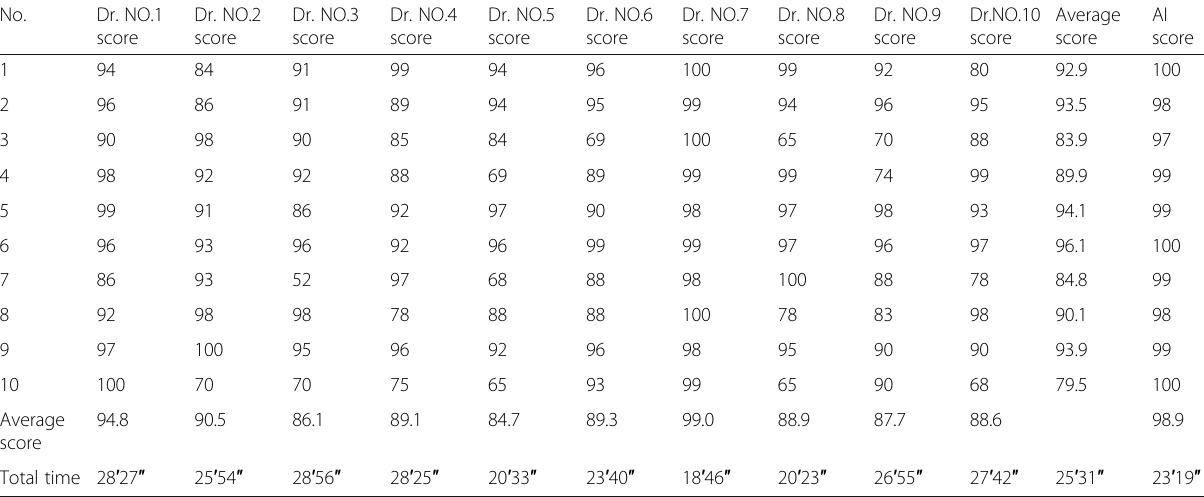
Table 4 Details for the competition results of all contestants